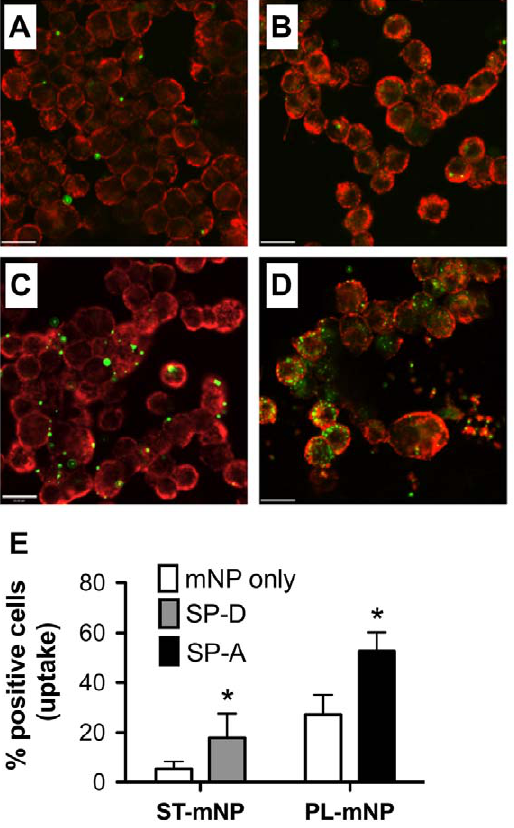
Figure 2. Nanoparticle uptake by alveolar macrophages in dependence on surfactant proteins as studied by confocal microscopy. Representative micrographs are shown for Starch- modified (ST) magnetite nanoparticles (mNP) (A, C) or Phosphatidyl- choline-modified (PL) mNPs (B, D) (1.532 6 10 10 /ml, in green) after 90 min exposition to alveolar macrophages (MH-S cells; membrane in red) in absence (mNP only in buffer (A, B) or presence of (C) SP-D (10 m g/ml) or (D) SP-A (10 m g/ml). Scale bar indicates a distance of 20 m m. (E) Particle uptake determined by visual counting of cells with at least one nanoparticle internalized related to total cell count (% positive cells). Data shown as mean 6 SD (n=14 images). Asterisk indicates a significant difference with p ,